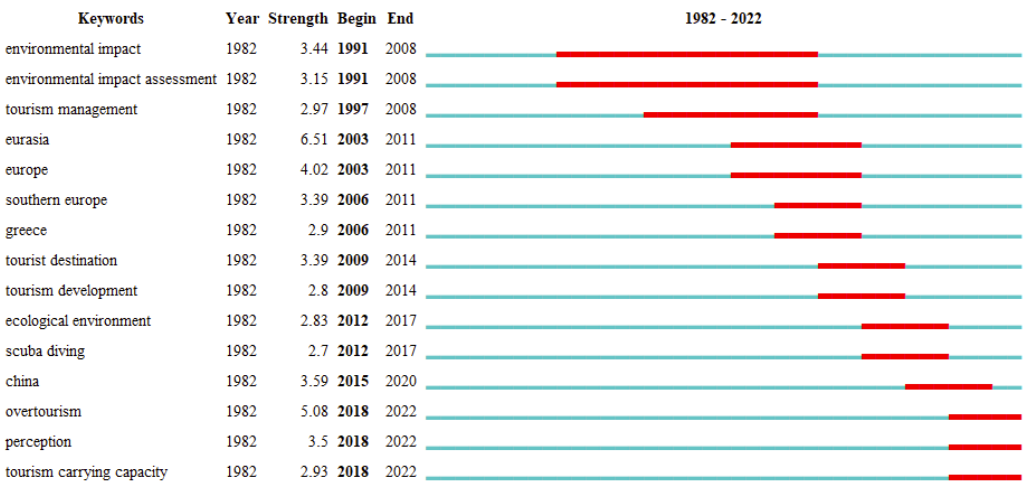
Figure 6. Co-occurrence analysis of emergent words (with a 5-year time slice).